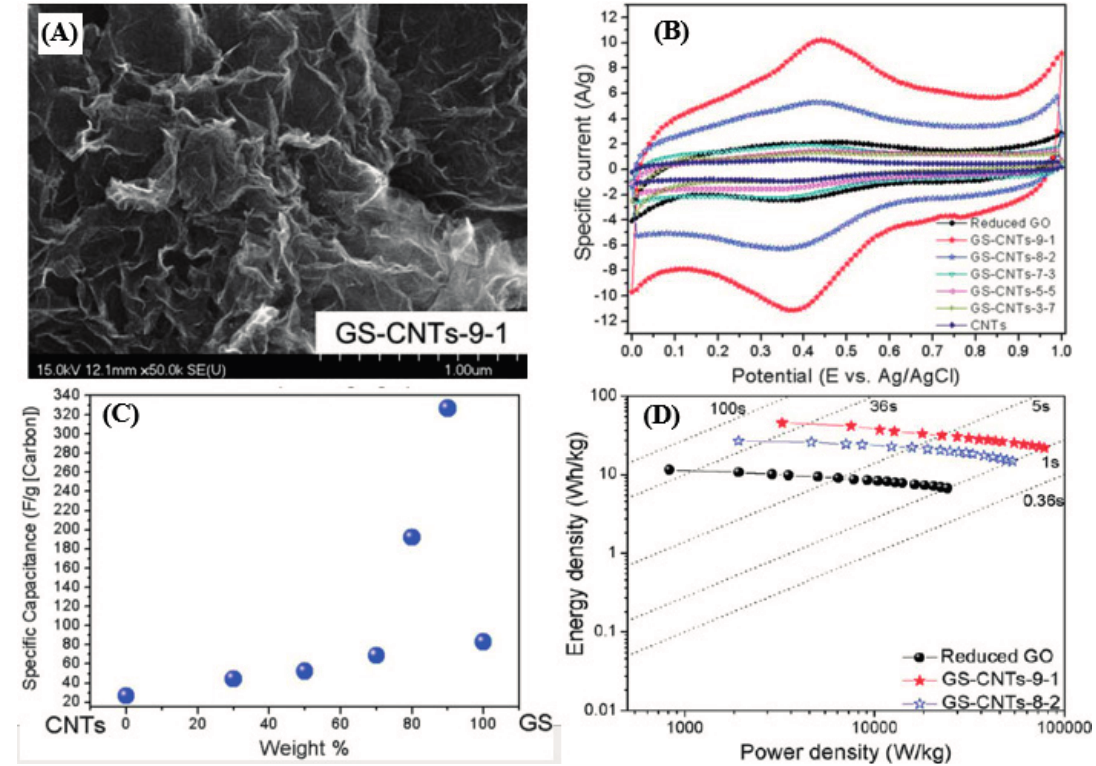
Figure 2. ( A ) FE-SEM image of GS-CNTs-9-1 (where the weight feed ratio of GO to MWNTs is 9:1). ( B ) CV curves measured at 20 mV·s − 1 in 0.5 M H 2 SO 4 for